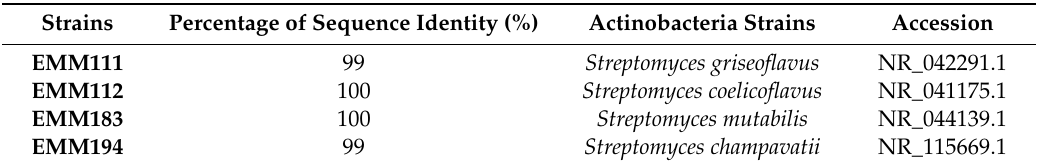
Table 4. Comparison of percent similarities between our 16S rRNA gene sequence and sequences present in the genomic database banks using NCBI